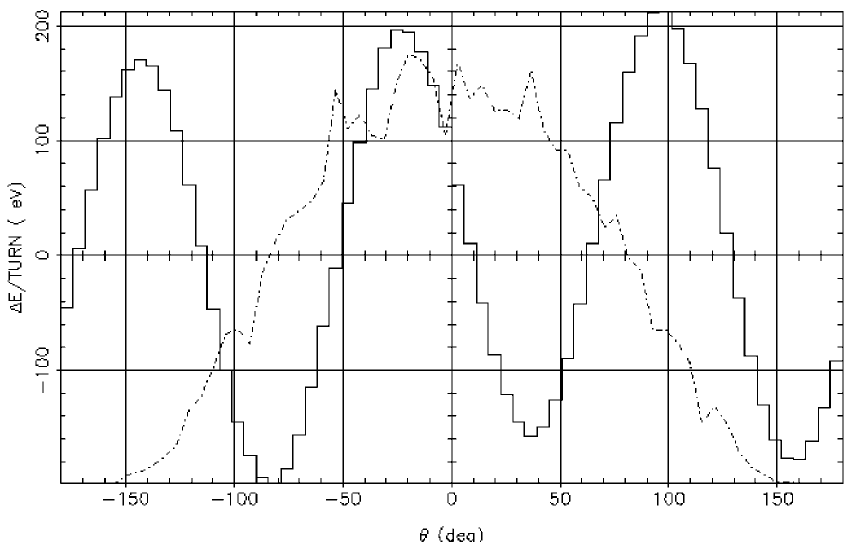
FIG. 1. Voltage vs rf phase (histogram) produced by an h (cid:1) 3 HOM resonance in the ring whose parameters are given in Table II, after 4 3 10 4 turns (0.014 s). The beam intensity is 4 3 10 13 protons. The longitudinal charge distribution is shown with the same binning by the dash-dotted curve.